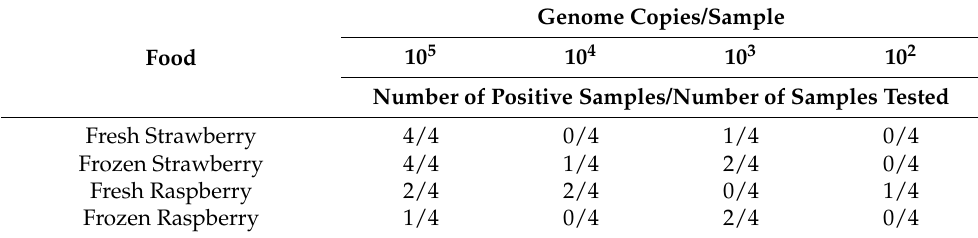
Food Table 3. Detection of NoV GII.4 on berries using capture by ApoH beads.